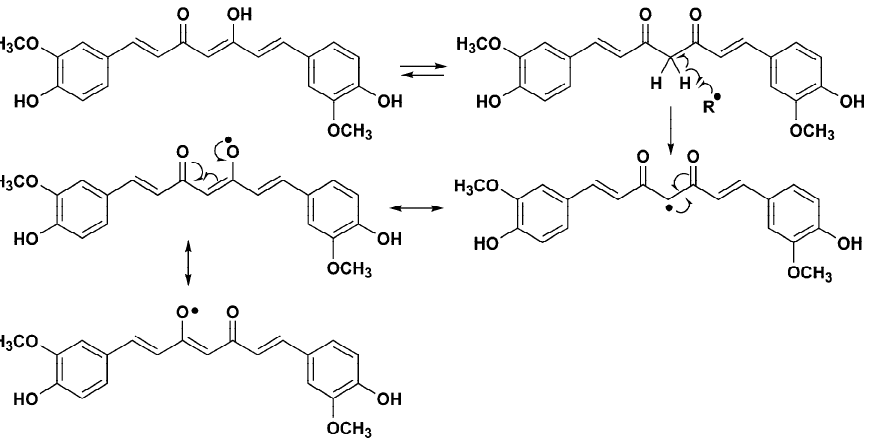
Figure 9. Methylene group as radical source in the curcumin molecule .